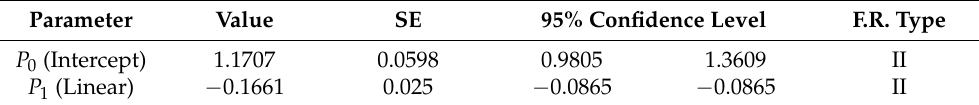
Table 3. Results of logistic regression analyses of the proportion of Tecia solanivora eggs killed by the adult female of Blattisocius tarsalis in the bioassay carried out under laboratory conditions. Parameter Value SE 95% Confidence Level F.R. Type P 0 (Intercept) 1.1707 0.0598 0.9805 1.3609 P 1 (Linear) − 0.1661 0.025 − 0.0865 − 0.0865 II